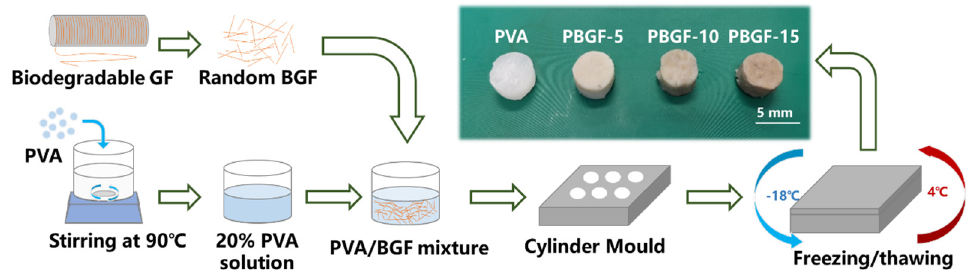
Figure 8. The manufacture process of BGF-reinforced PVA hydrogel composites.